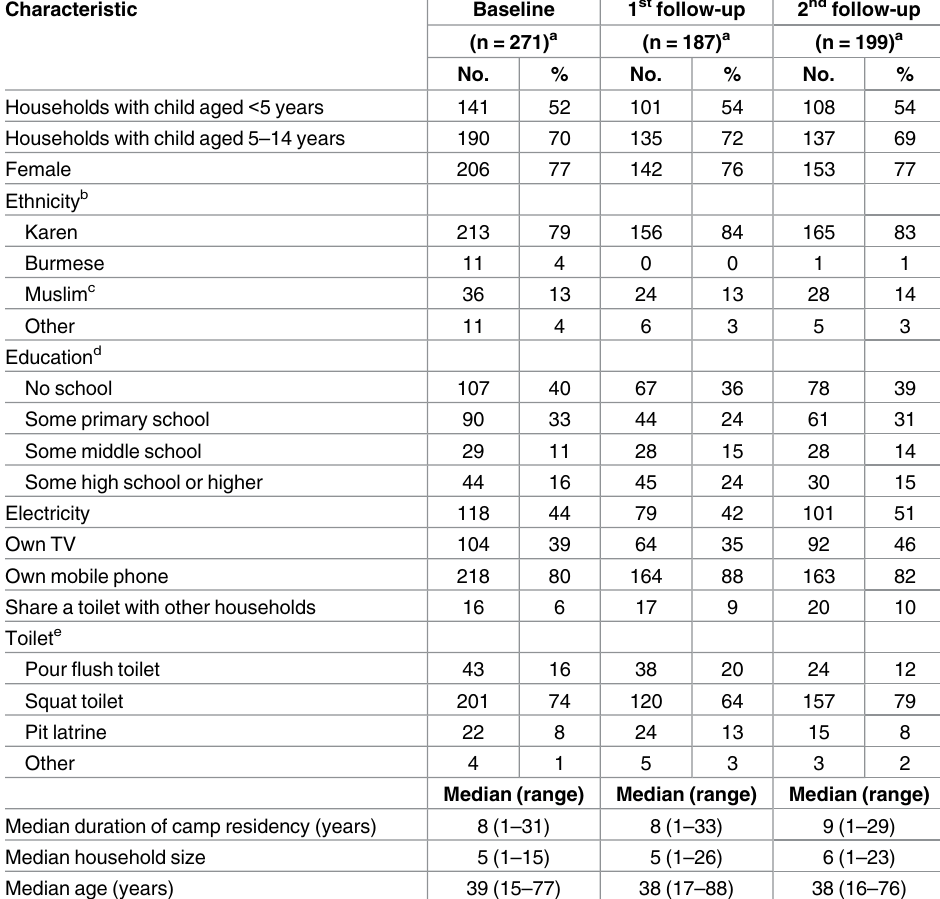
Table 2. Socio-demographic characteristics of respondent households in the surveysconducted 1 month before (baseline), and 3 and 12 months after (first and second follow-up) an oral cholera vacci- nation campaign, Maela Camp, 2013. Characteristic Baseline